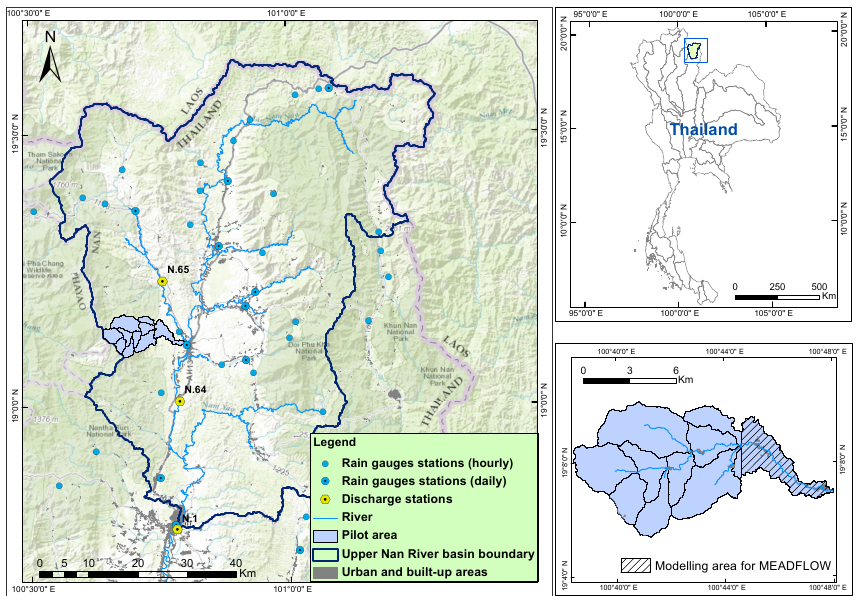
Figure 1. Study area: upper Nan River basin (left), a pilot catchment (right